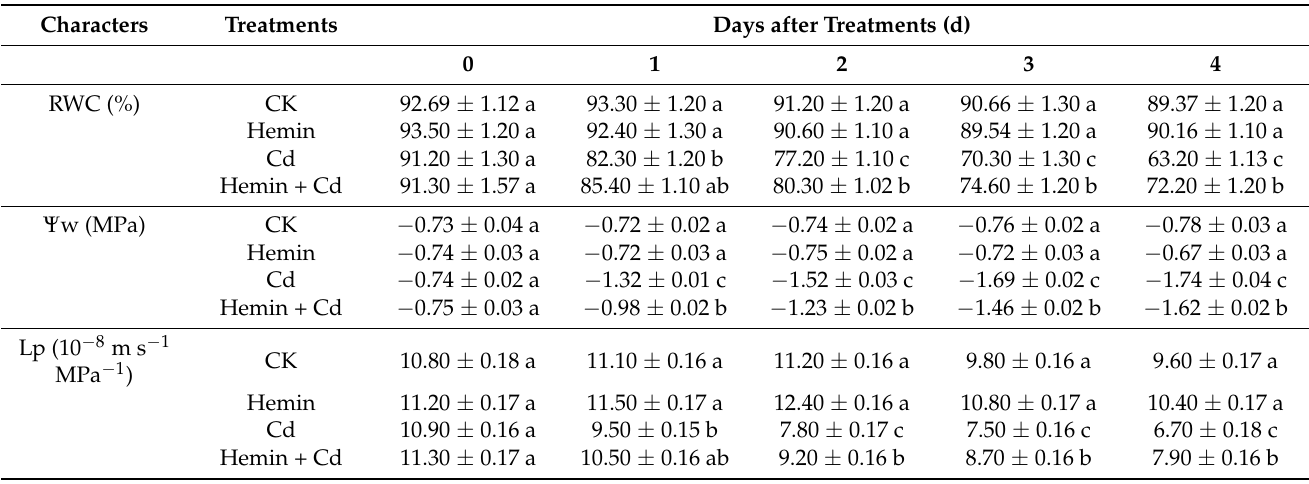
Table 2. Effects of hemin on leaf relative water content (RWC), leaf water potential ( Ψ w), and root hydraulic conductance (Lp) under Cd